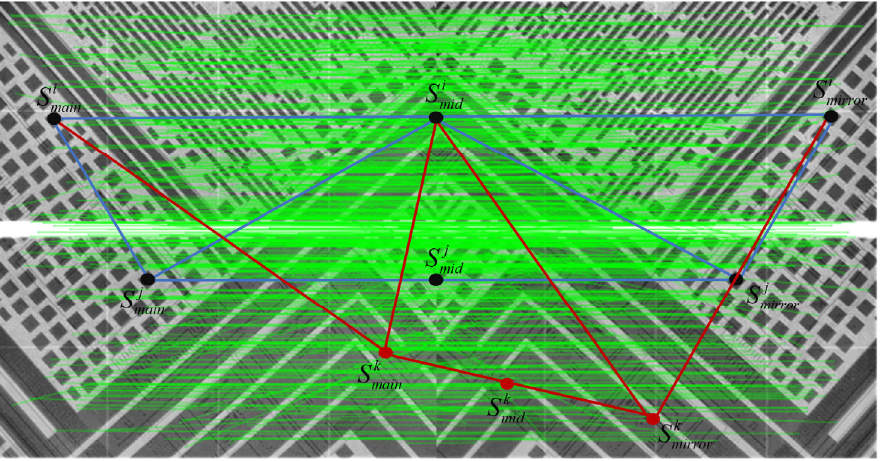
Figure 3. Schematic diagram of feature-point screening.